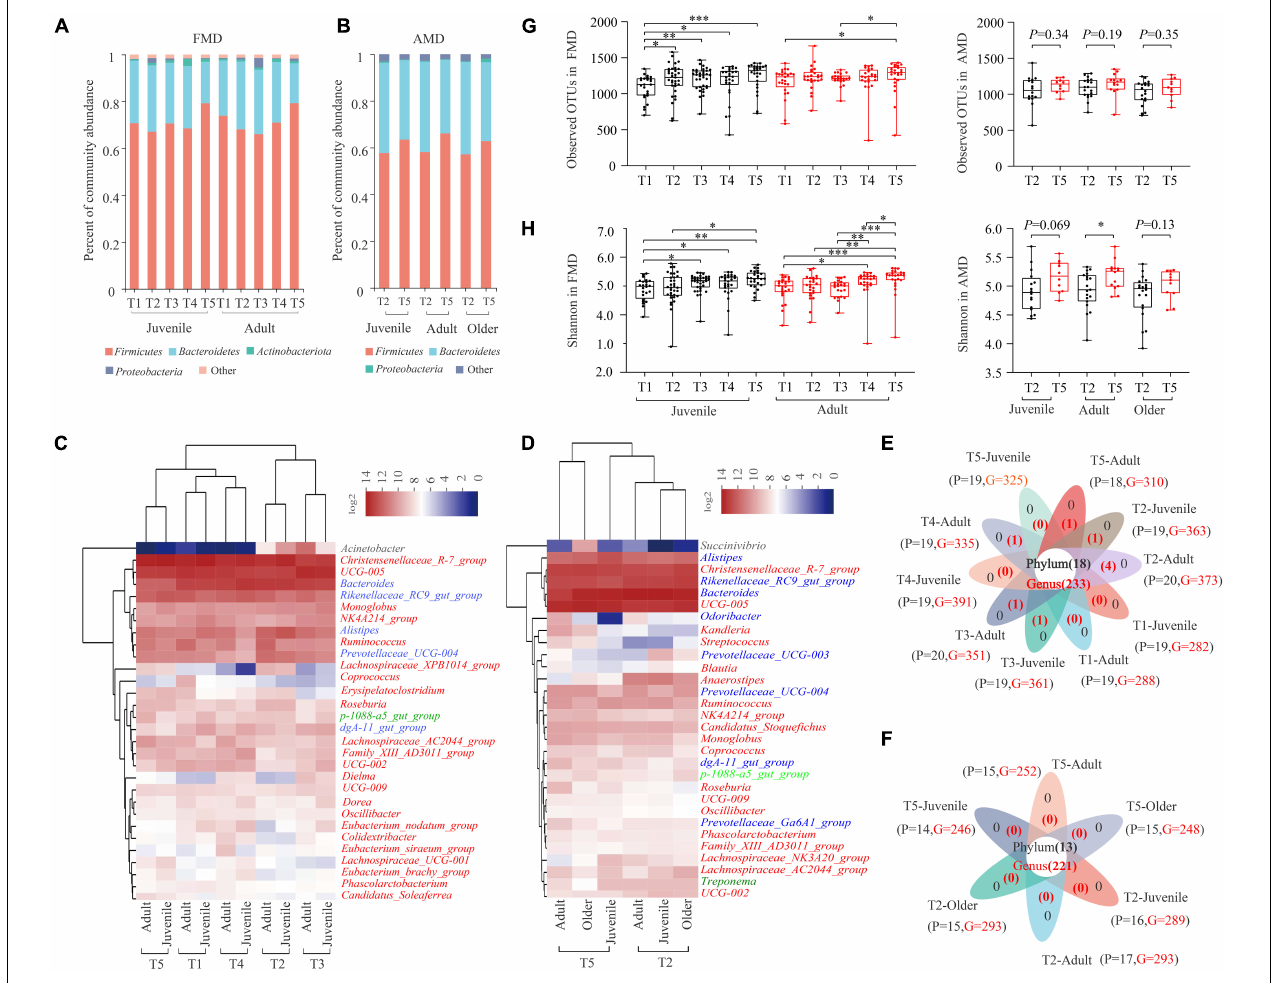
FIGURE 1 | Gut microbial composition of the FMD and AMD. Histogram of relative abundance of individual bacteria phyla of the FMD (A) and the AMD (G) . Relative abundance of dominant phyla in the FMD (A) and the AMD (B) . Heat map analysis based on identifiable bacterial genera with the relative abundance of top30 for the FMD (C) and the AMD (D) . The red, blue, light green, black, and dark green letters represent phylum Firmicutes , Bacteroidetes , Planctomycetes , Proteobacteria , and Spirochaetes , respectively. Analysis of core and unique bacteria of the FMD (E) and AMD (F) at phylum and genus levels via Venn plots. Seasonal variation of α diversity in the gut microbiota of the musk deer based on Sobs index (G) and Shannon index (H) . ∗ p < 0.05 (Wilcoxon rank-sum test), ∗∗ p < 0.01, and ∗∗∗ p < 0.001. ns, not